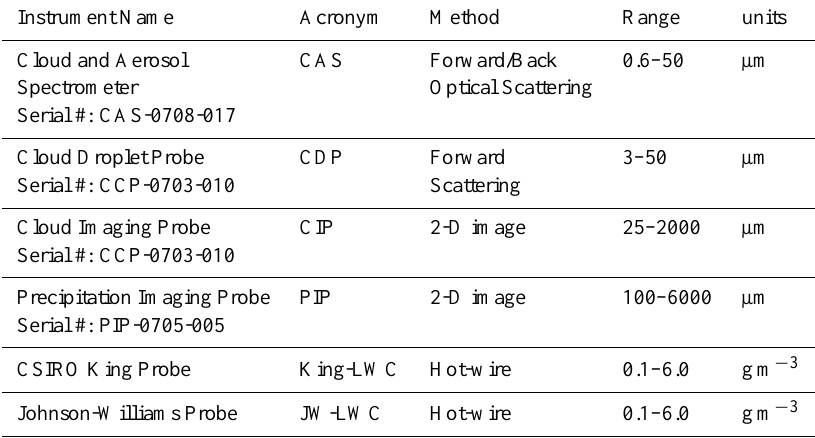
Table 1. Instruments on the ARCPAC